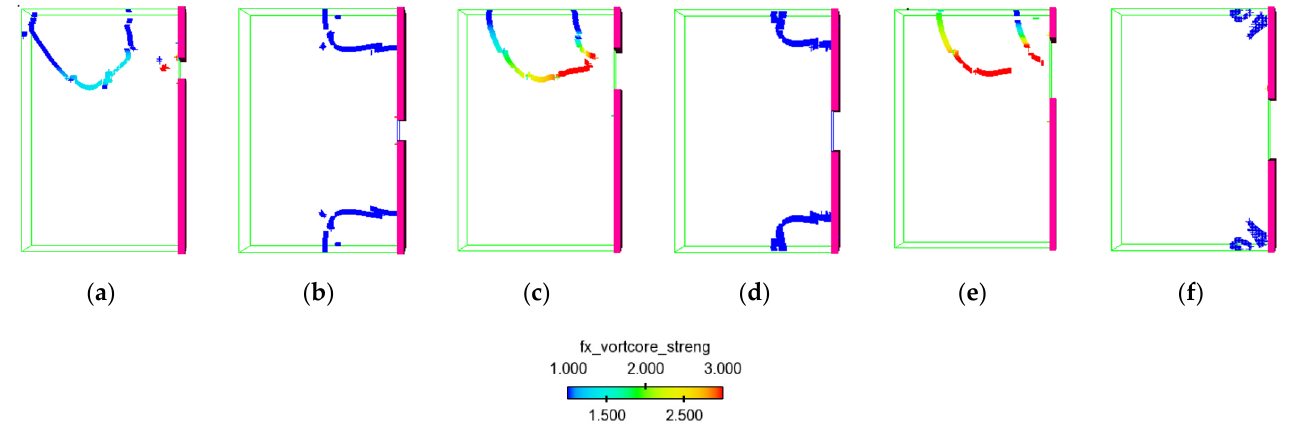
Figure 12. f x –vortex core strength at early stage of dam breach at t = 1.5 s. ( a ) 7A, ( b ) 7B, ( c ) 8A, ( d ) 8B, ( e ) 9A, ( f ) 9B.